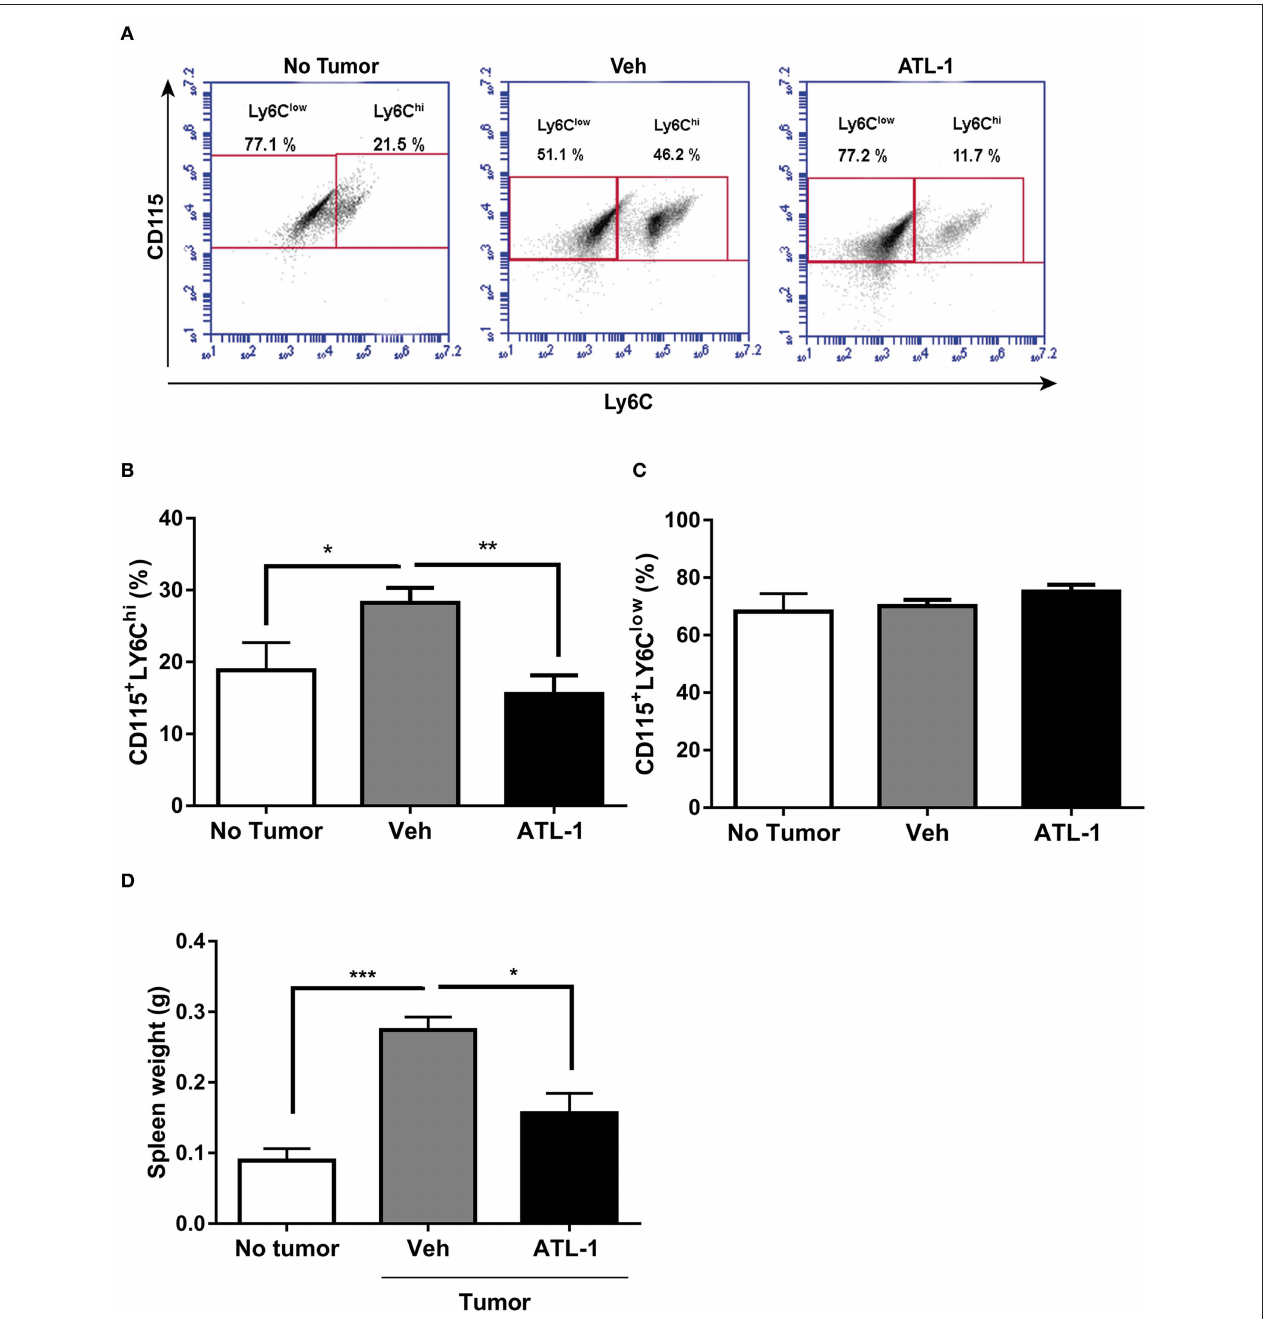
FIGURE 3 | ATL-1 treatment decreases CD115 + LY6C hi monocyte population in the spleen of tumor-bearing mice. C57/BL6 mice were inoculated with B16/F10 tumor cells. After 14 days, ATL-1 (1 µ g/animal) or vehicle (20 µ L ethanol) was administered. On 21st day, the animals were sacrificed, the spleens dissected and weighted, and monocytes isolated for further analysis by flow cytometry. (A) Representative dot plot used to quantify the percentage of CD115 + /LY6C hi and CD115 + /LY6C low populations within the selected gate. (B) CD115 + LY6C hi ( n = 8); (C) CD115 + LY6C low. ( n = 8); (D) spleen weight ( n = 6). Data are expressed as mean ± SEM. * p < 0.05; ** p < 0.01; *** p < 0.001 by unpaired t -test or ANOVA test, followed by Bonferroni test.